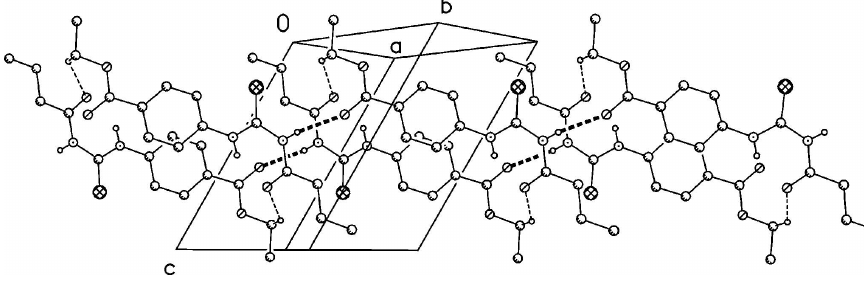
Figure 2 Packing diagram of I showing classical and "weak" H bonds as thick or thin dashed bonds respectively. The double chain pattern is